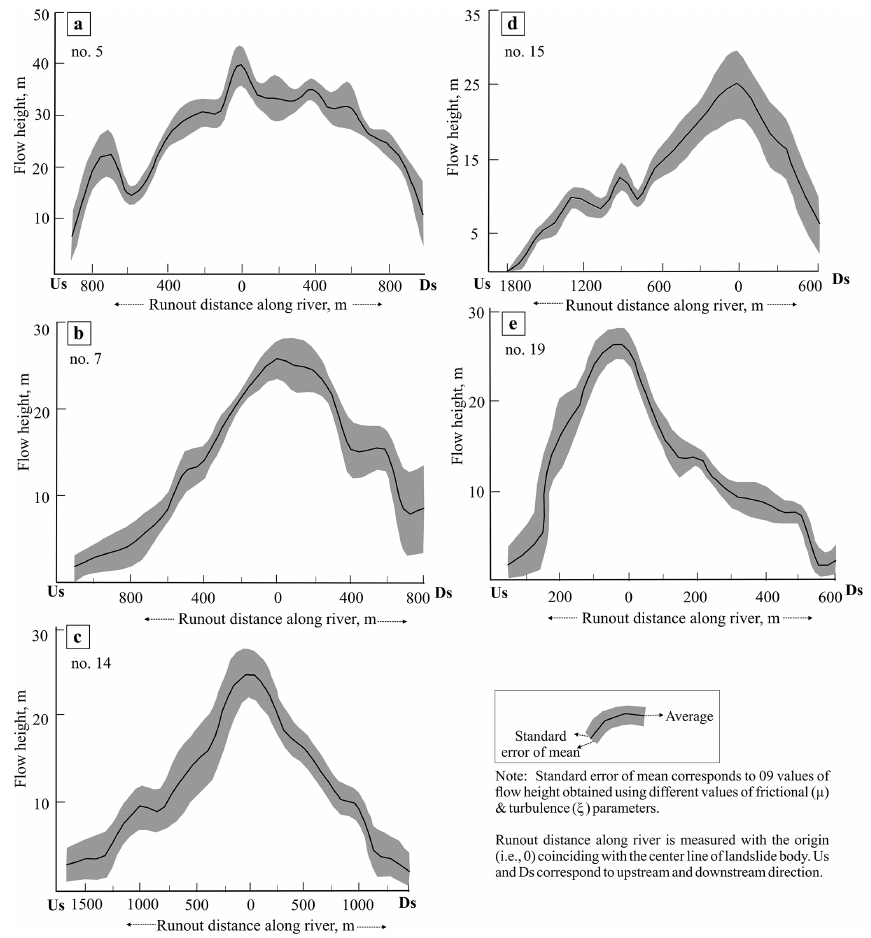
Figure 14. Results of the run-out analysis at different values of µ and ξ . µ and ξ refer to the coefficient of friction and turbulence, respec-